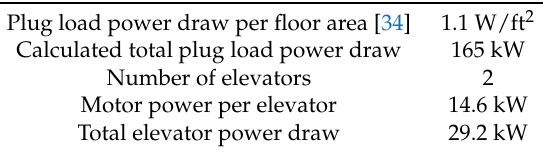
Table A7. Electrical load